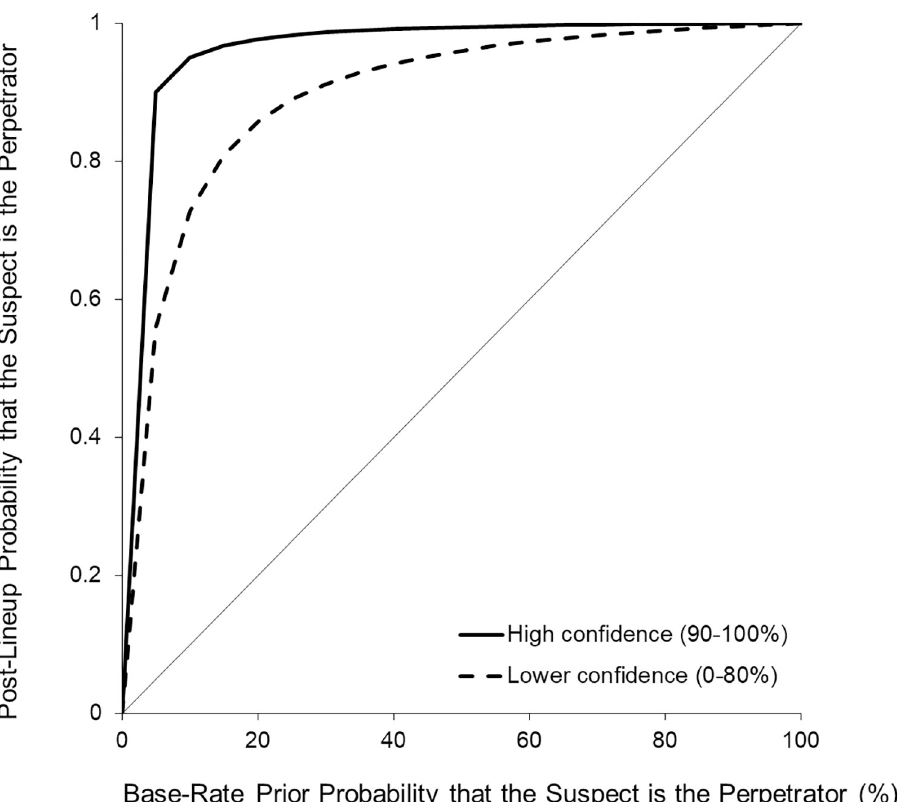
Fig 2. Post-lineup probability that the suspect is the perpetrator as a function of the base rate of target-presence for highly confident and less confident participants.